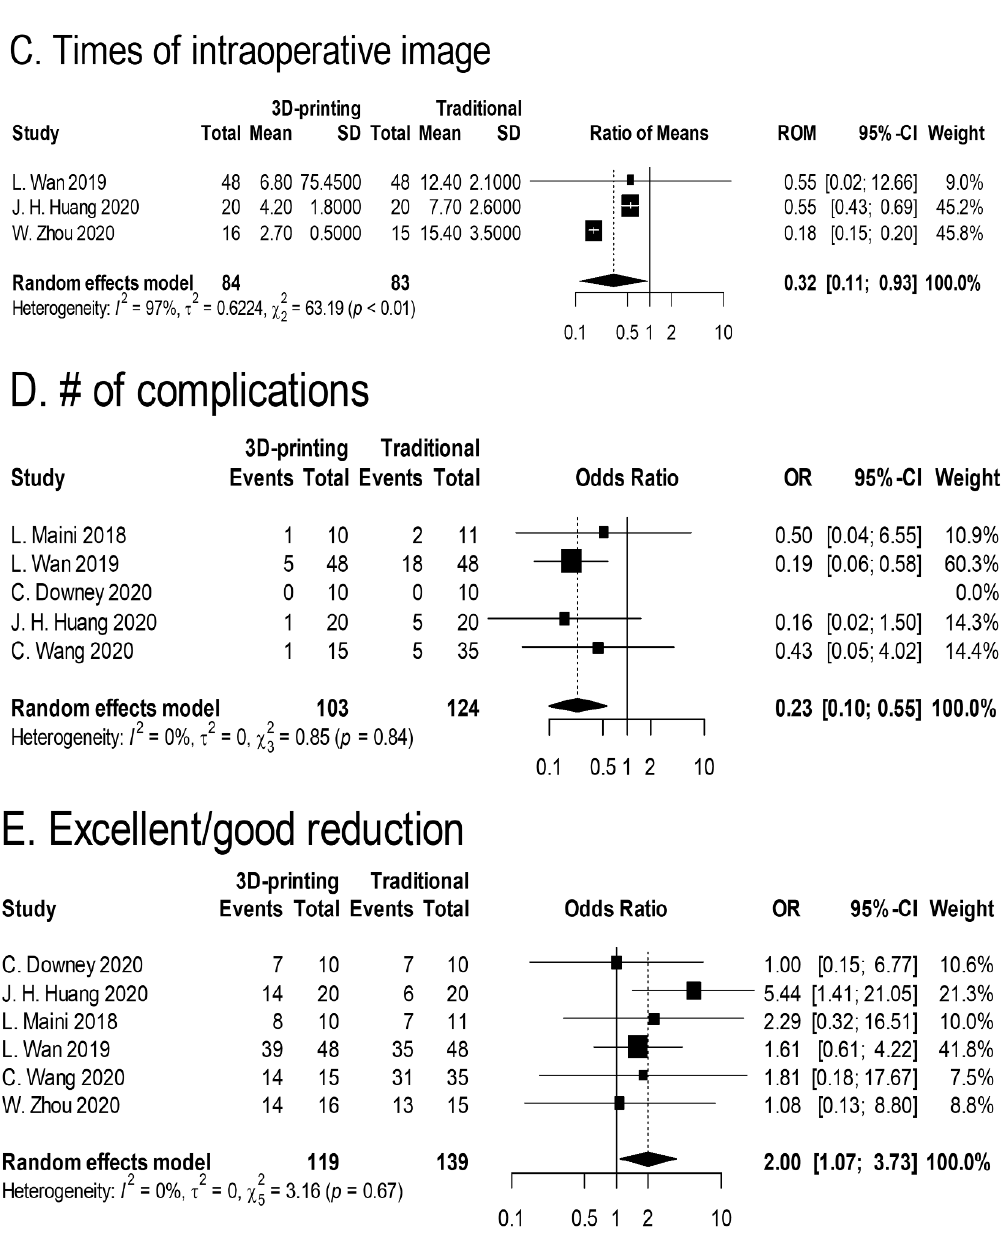
Figure 5. Forest plots of ( A ) surgical duration (minutes). Overall RoM (95% CI) = 0.77 (0.58, 1.03), I 2 = 95%; ( B ) amount of blood loss (mL). Overall RoM (95% CI) = 0.79 (0.59, 1.06), I 2 = 81%; ( C ) times of intraoperative imaging. Overall RoM (95% CI) = 0.32 (0.11, 0.93), I 2 = 97%; ( D ) number of complications. Overall OR (95% CI) = 0.23 (0.10, 0.55), I 2 = 0%; ( E ) excellent/good reduction. Overall OR (95% CI) = 2.00 (1.07, 3.73), I 2 = 0%.